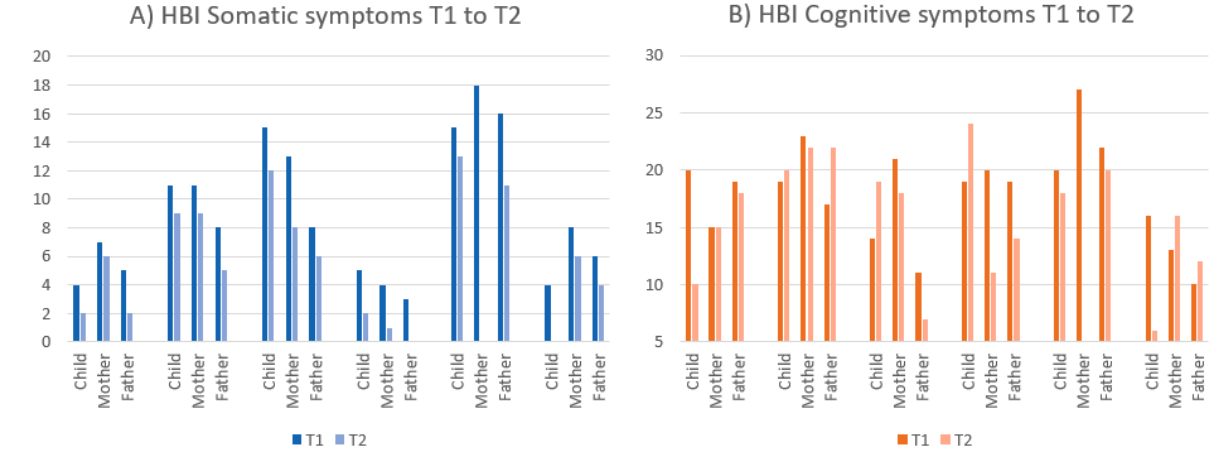
Figure 5. Ratings on the ( A ) somatic and ( B ) cognitive sub-scales of the HBI at T1 and T2 for each Figure 5 . Ratings on the ( A ) somatic and ( B ) cognitive sub-scales of the HBI at T1 and T2 for each Figure 5 . Ratings on the ( A ) somatic and ( B ) cognitive sub-scales of the HBI at T1 and T2 for each Figure 5 . Ratings on the ( A ) somatic and ( B ) cognitive sub-scales of the HBI at T1 and T2 for each family. Lower scores imply lower symptom burden. family. Lower scores imply lower symptom burden. family. Lower scores imply lower symptom burden. family. Lower scores imply lower symptom burden.